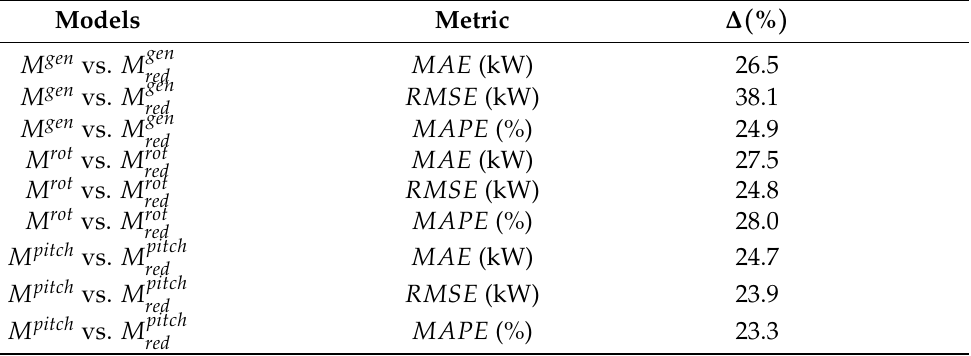
Table 11. Average percentage reduction in error metrics for the full models with respect to the reduced models: